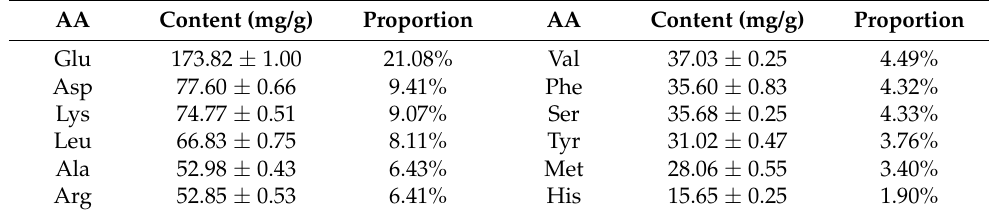
Table 1. Amino acid composition of small yellow